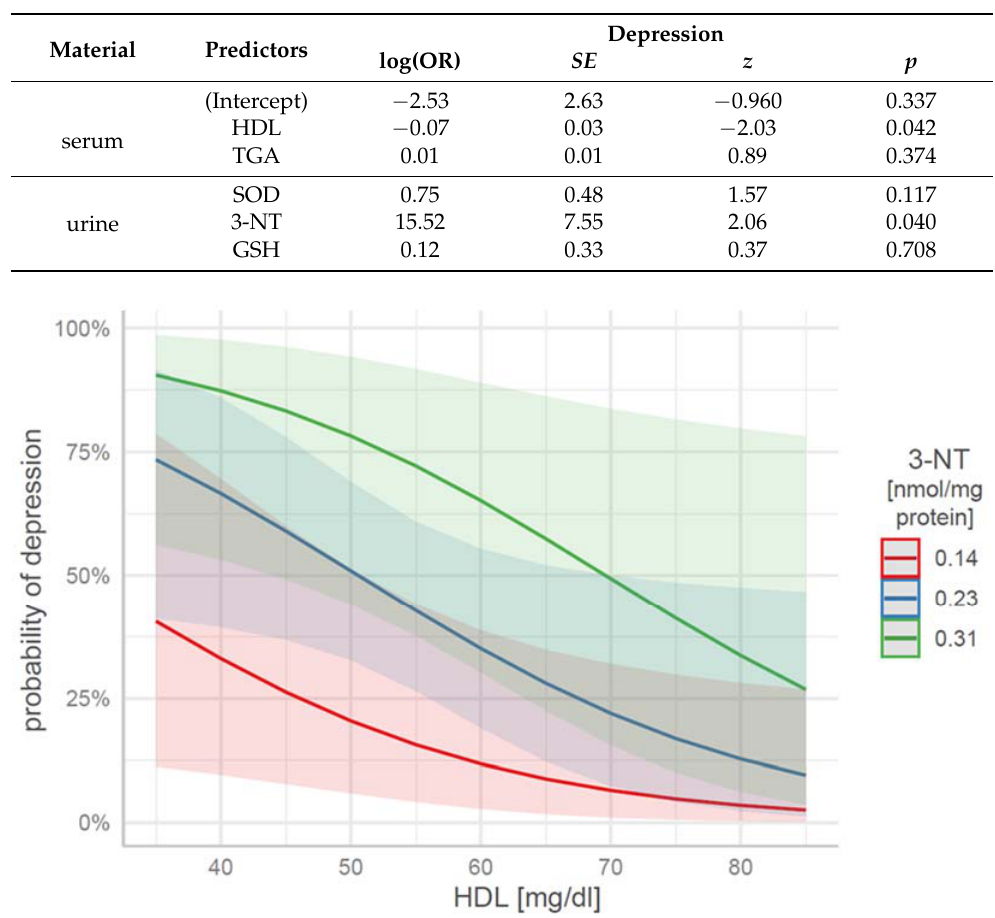
Figure 1. Expected probabilities of depression as a function of the HDL and 3 ‐ NT parameters, in the case of 3 ‐ NT for values of M (0.23) and within one standard deviation, 0.14 ( M ‐ 1 SD ), 0.31 ( M +1 SD ). The estimated marginal medians (predicted values) for the response variable for sig ‐ nificant predictors are presented in Table 4. From the data in Figure 1 and Table 4, patients with HDL < 40 mg/dl and 3 ‐ NT > 0.3 nmol/mg protein were more likely to be depressed, whereas patients with HDL > 80 mg/dl and 3 ‐ NH < 0.15 nmol/mg protein were less likely to be depressed.